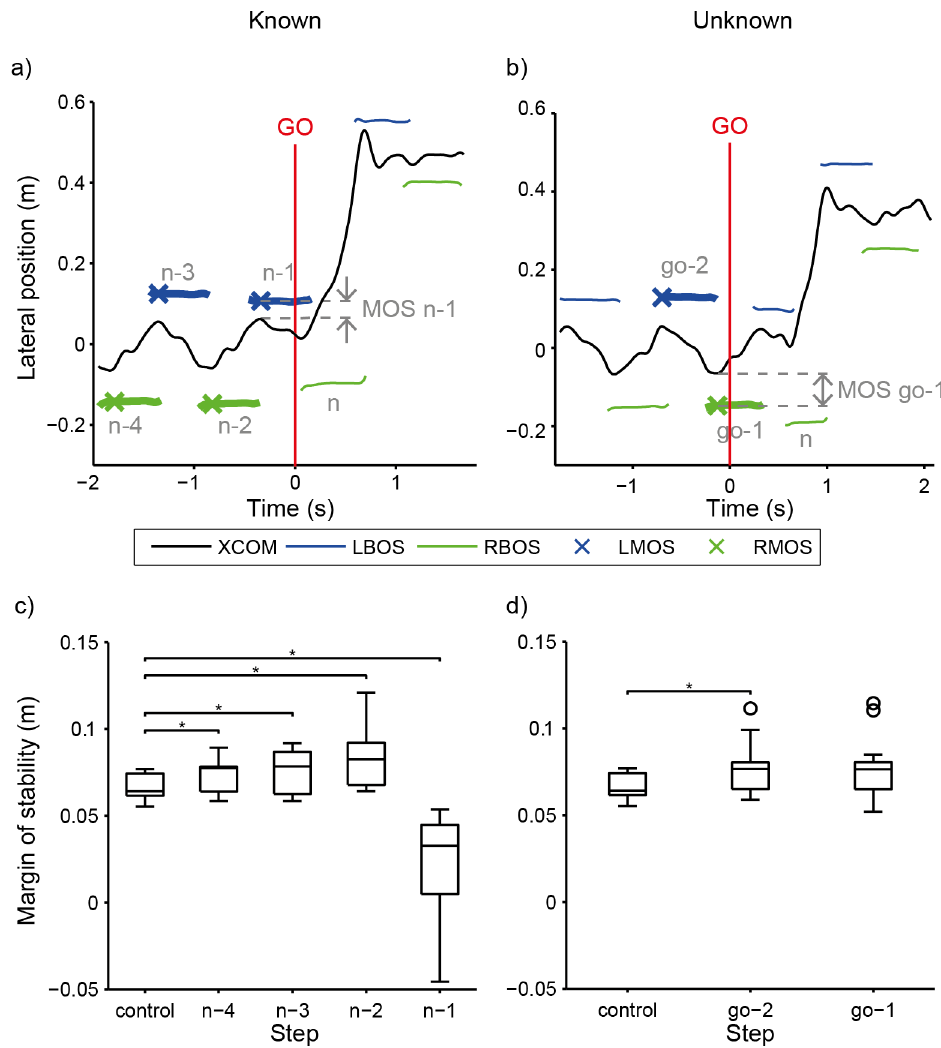
Fig 3. Minimum Margin of stability. Example margin of stability data for one subject during a) a Known left trial and b) an Unknown left trial. Left (L) and Right (R) minimum margin of stability (MOS), denoted by “ x ” marker at each step, is the minimum distance between the base of support (BOS) and extrapolated center of mass (XCOM). c) Minimum margin of stability, Known condition. The minimum margin of stability was significantly larger for the n-4 through n-2 steps, and significantly smaller one step prior to the maneuver, the n-1 step (ipsilateral to the target), compared to the control step. d) Minimum margin of stability, Unknown condition. Minimum margin of stability was significantly larger 2 steps before the “ GO ” signal, the go-2 step. ( * )Step is significantly different (p < 0.05) from control. For c) and d) the Box plots are collapsed across limb side to show main effect of step. Each box represents 14 data subjects ’